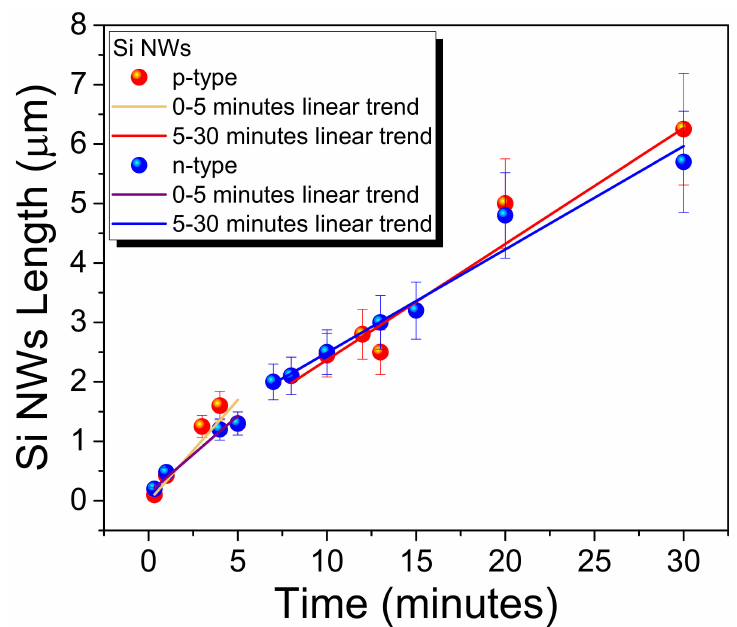
Figure 3. Si NWs length as a function of the etching time for p -type substrates (red dots) and n -type substrates (blue dots). Both n - and p -type correspond to a resistivity of about 1–5 Ω ·